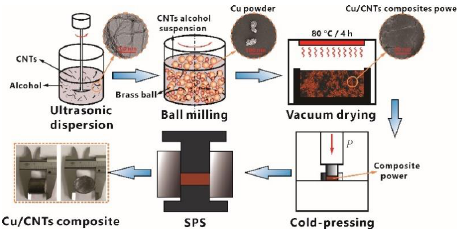
Figure 1. Schematic illustration of the fabrication process of Cu / carbon nanotube (CNT)